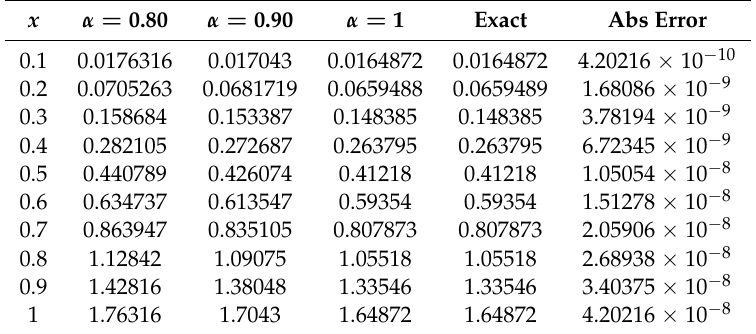
Table 5. Third order approximate results for different values of α at t = 1 of Example